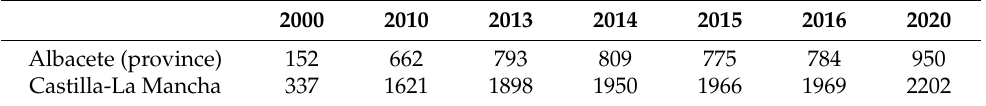
Table 3. Growth in rural accommodations in Castilla-La Mancha